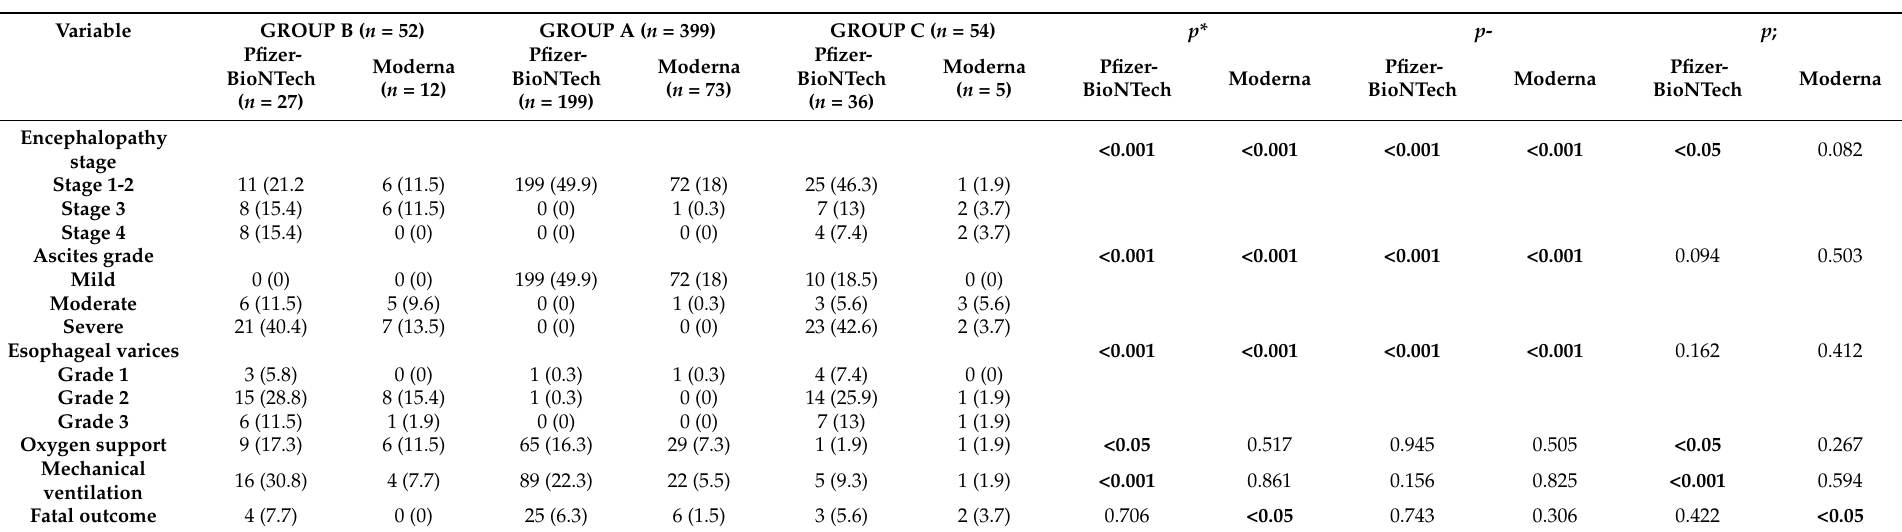
Table 3. The impact of primary vaccination with mRNA vaccines on hospital outcomes regarding COVID-19 status and